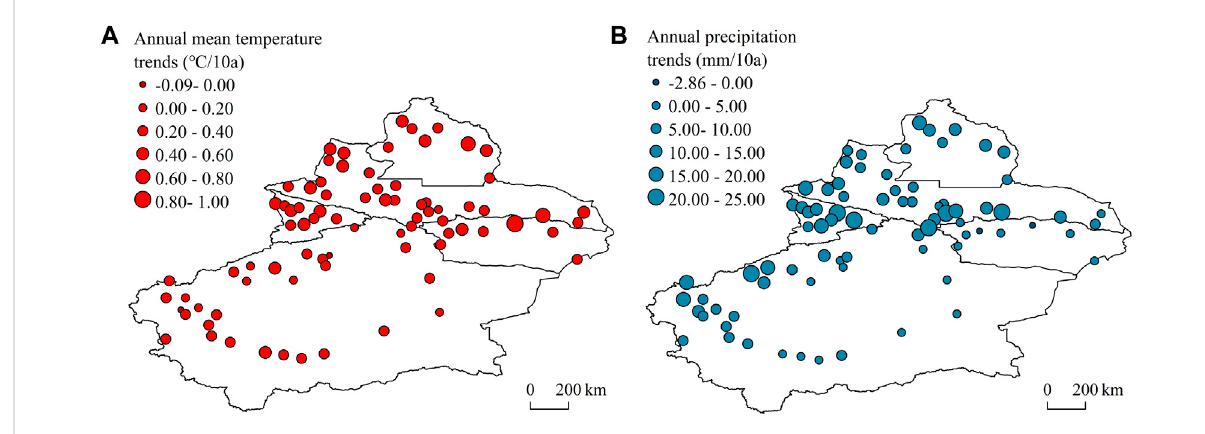
FIGURE 3 Spatial distributions of the variation trends in annual mean temperature (A) and precipitation (B) in XJ and its